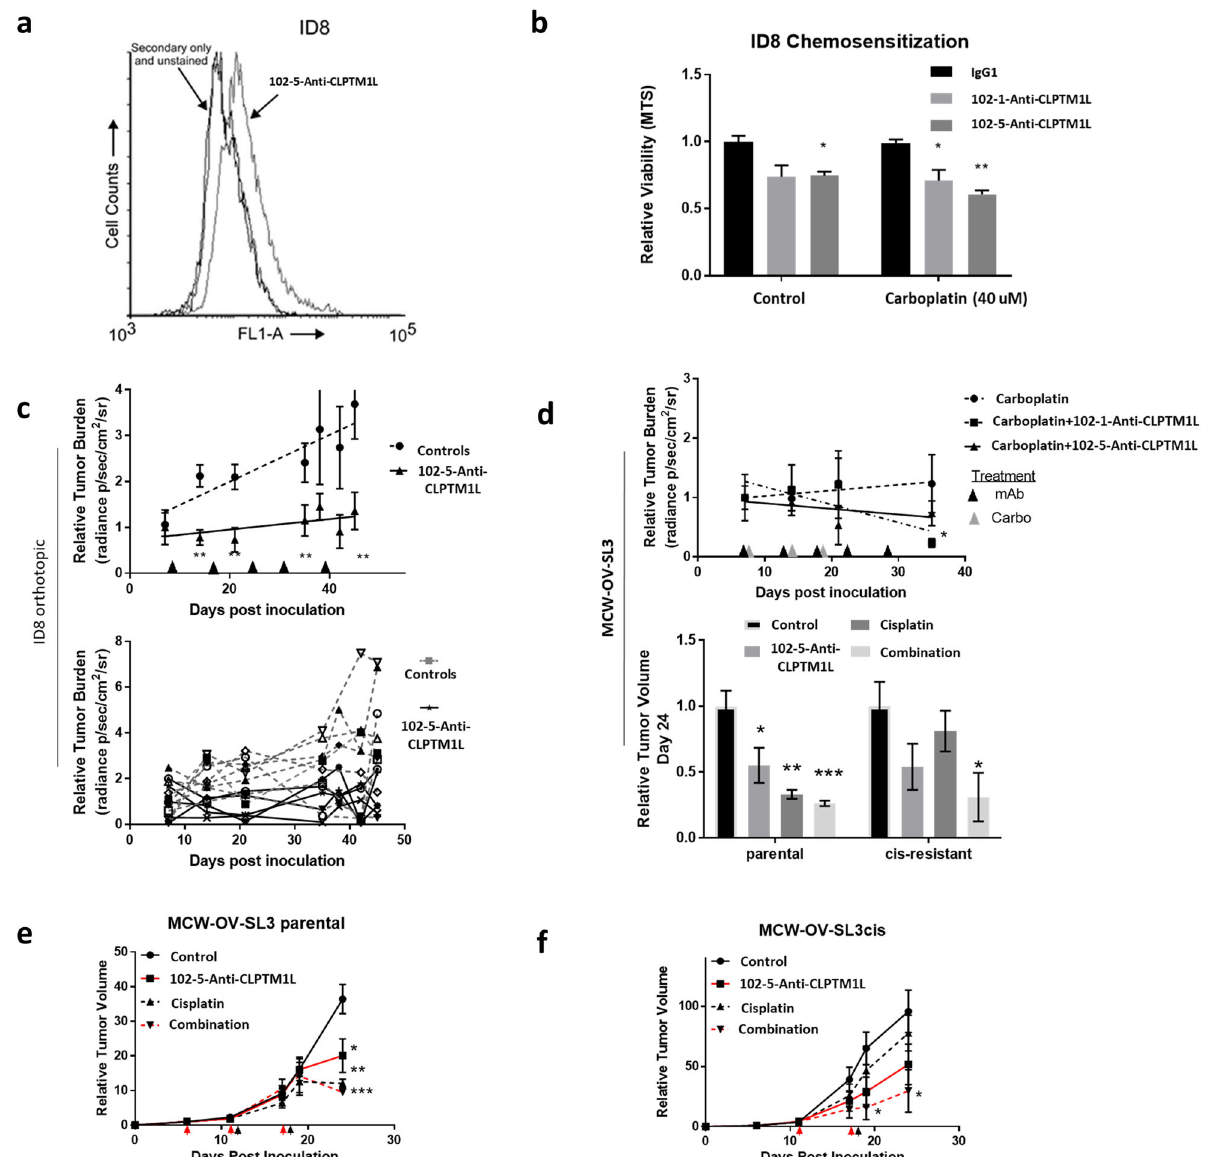
Fig. 5 Orthotopic syngeneic isograft and human xenograft ovarian cancer models. a Flow cytometry histograms of fl uorescent labeling of live ID8-luc cells with 102-5 anti-CLPTM1L primary and Alexa fl uor-488-conjugated secondary antibodies. b Viability of ID8-luc cells treated with 100 nM 102-5 anti-CLPTM1L and/or 40 µM carboplatin for 5 days. Error bars represent standard error of the mean. c Relative tumor burden as measured by luciferin luminescence live animal imaging of control vs. 10 mg/kg 102-5 anti-CLPTM1L treated ID8-luc isograft groups (top panel) and individual animals (bottom panel). Error bars represent standard error of the mean. d Relative tumor burden as measured by luciferin luminescence live animal imaging of mice treated with 10 mg/kg carboplatin plus either control, 102-1 or 102-5 anti-CLPTM1L (10 mg/kg). Error bars represent standard error of the mean. e Final relative mean volumes of MCW-OV-SL3 and MCW-OV-SL3-Cis R xenograft tumors 24 days post-inoculation. Error bars represent standard error of the mean. f Mean volumes of MCW-OV-SL3 and MCW-OV-SL3-Cis R xenograft tumors relative to group mean volume after sorting from days 0 to 24 post-inoculation. * p < 0.05, ** p < 0.005, *** p < 0.0005. Error bars represent standard error of the